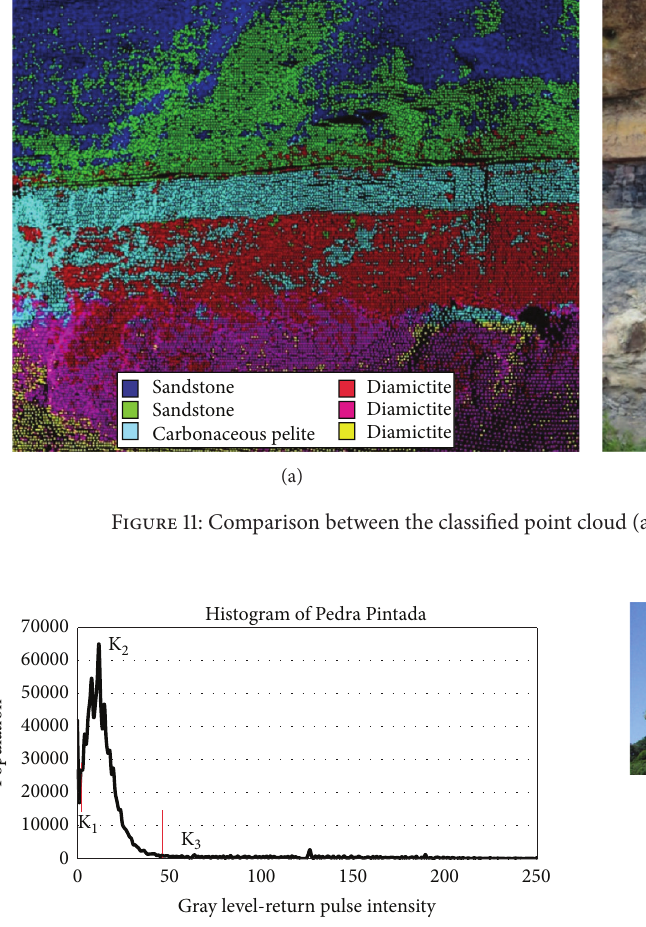
Figure 12: Histogram from the return intensity values from the Pedra Pintada outcrop. The red vertical lines separate the clusters that were user-defined and applied in the K-Clouds software.